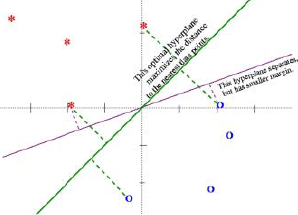
Fig.2. Choosing the optimum hyperplane which maximizes the